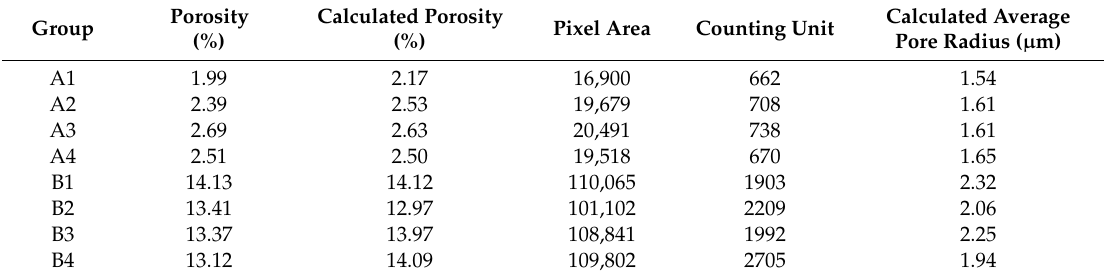
Table 3. Binary parameter statistics.